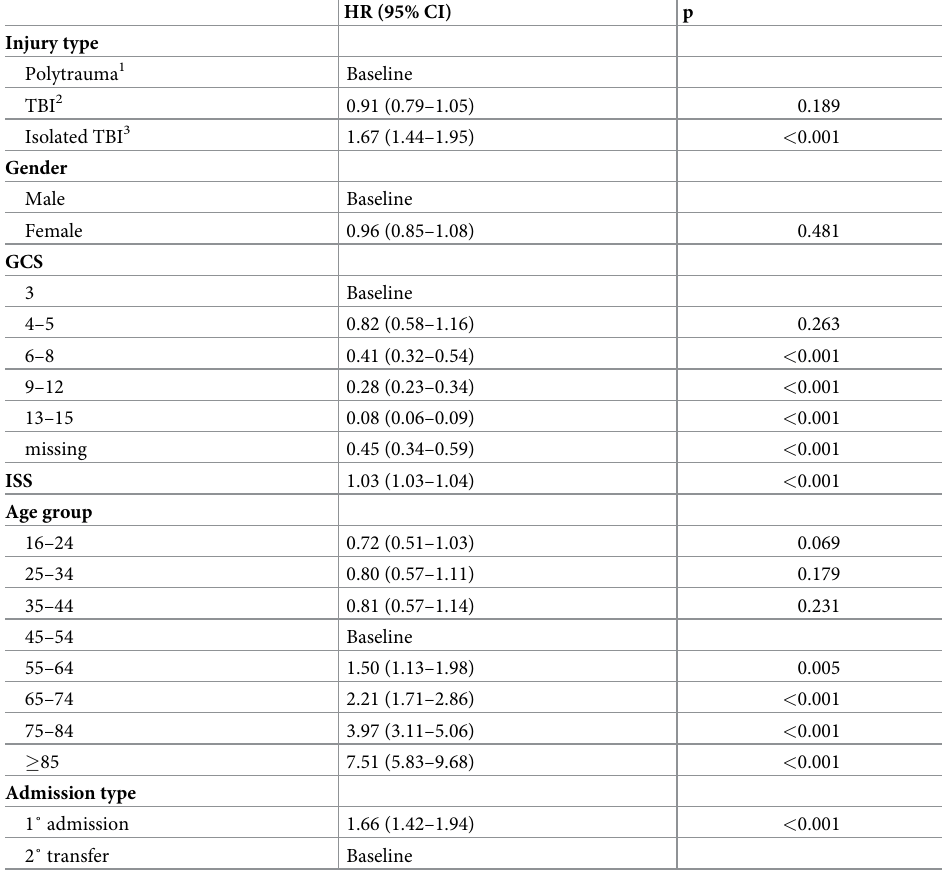
Table 3. HR for death from adjusted Cox proportional hazard